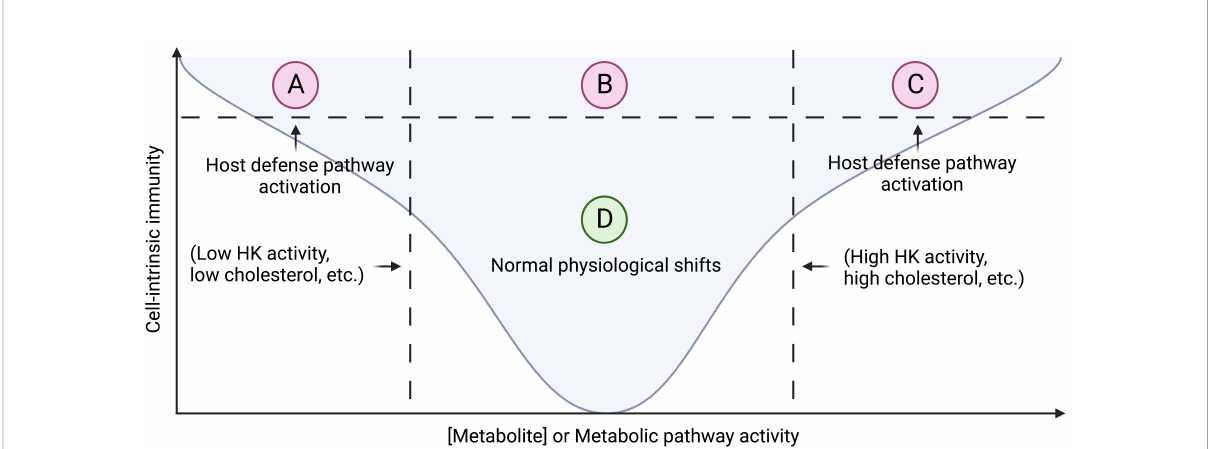
FIGURE 1 A Goldilocks zone of physiologic shifts in metabolic activity with guard circuits surveying wide perturbations. (A) Low concentration of a monitored metabolite or metabolic activity can lead to increased cell-intrinsic immunity through in fl ammasome activation in the case of low hexokinase (HK) activity or IFN production and ISG expression in low cholesterol biosynthesis. (B) Physiological range of host-adaptive changes in metabolite concentration and metabolic activity does not preclude cell-intrinsic immunity through orthogonal in fl ammasome activation such as monitoring for direct microbial ligands. (C) High concentration of a monitored metabolite or metabolic activity can lead to increased cell- intrinsic immunity through in fl ammasome activation in the case of high hexokinase (HK) activity or cholesterol accumulation. (D) A Goldilocks zone of allowed host-adaptive changes in metabolite concentration and metabolic activity without incurring cell-intrinsic immune responses such as in fl ammasome